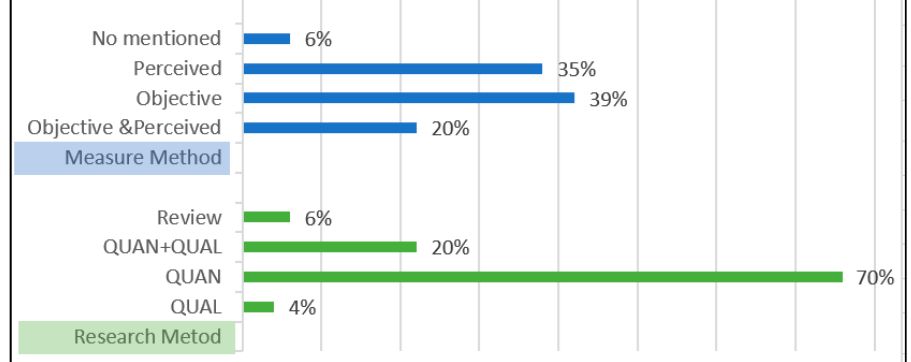
Figure 3. The proportions of different measurement methods and research methods.